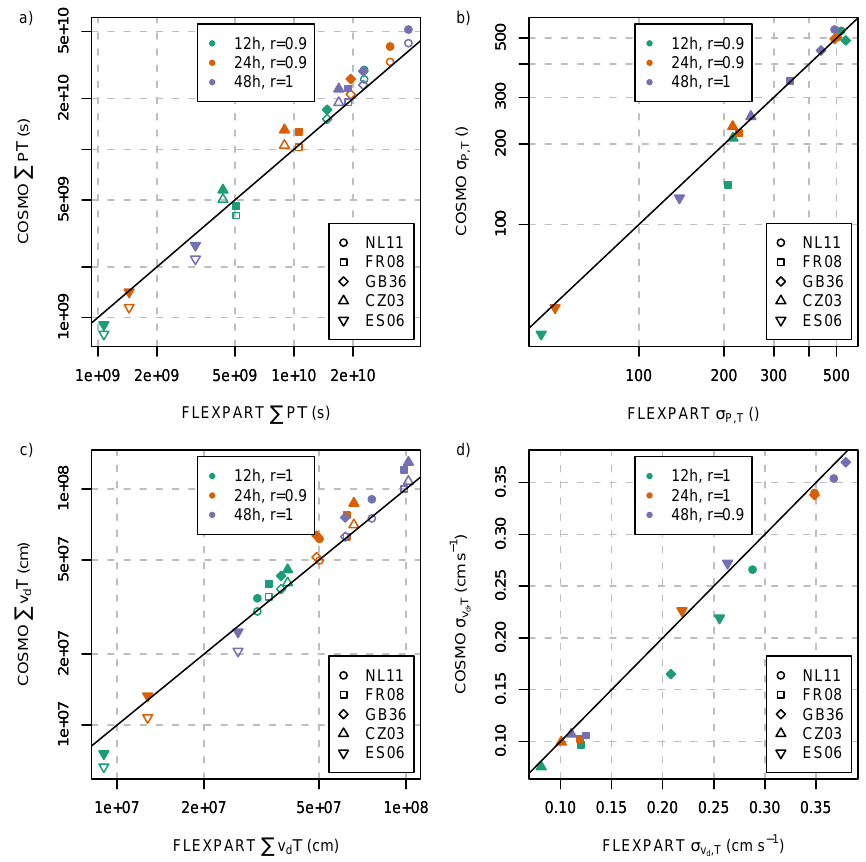
Fig. 9. Catchment area parameters (a) population sum P P T , (b) population variability σ P,T , (c) deposition sum P v d T and (d) deposition variability σ v as derived by COSMO LPDM versus those derived by FLEXPART. Solid symbols represent original COSMO LPDM d ,T results, open symbols represent parameters derived with scaled COSMO LPDM residence times. r gives the Spearman rank correlation